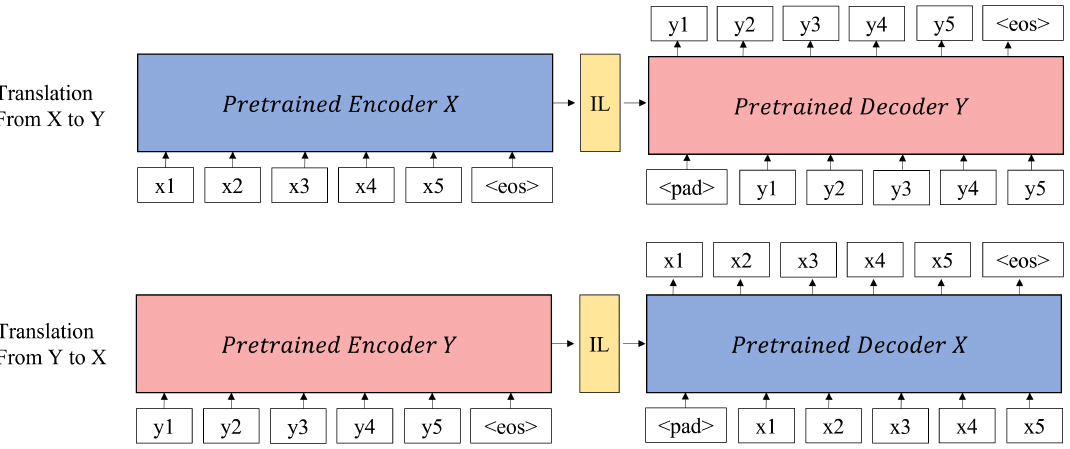
Figure 2. Fine-tuning of the cross-connected model. IL means the additional intermediate layer. We initialize the encoder with the source language pre-trained encoder and the decoder with the target language pre-trained decoder.